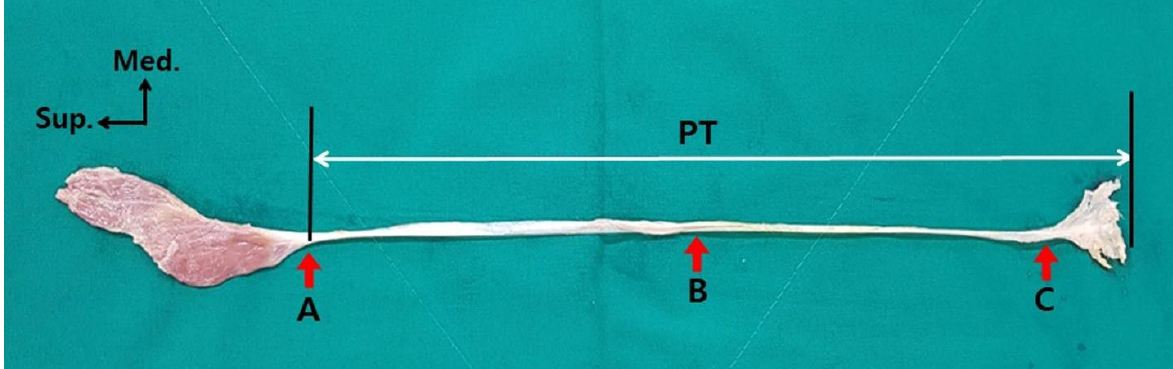
Figure 1. Reference point for measuring the width and thickness of the PT (red arrow): point A is the junction of the belly and tendon, point B is the mid-point of the total tendon length, and point C is the point where the tendon begins to extend. PT: plantaris tendon; Sup.: superior; Med.: medical. Statistical Analysis